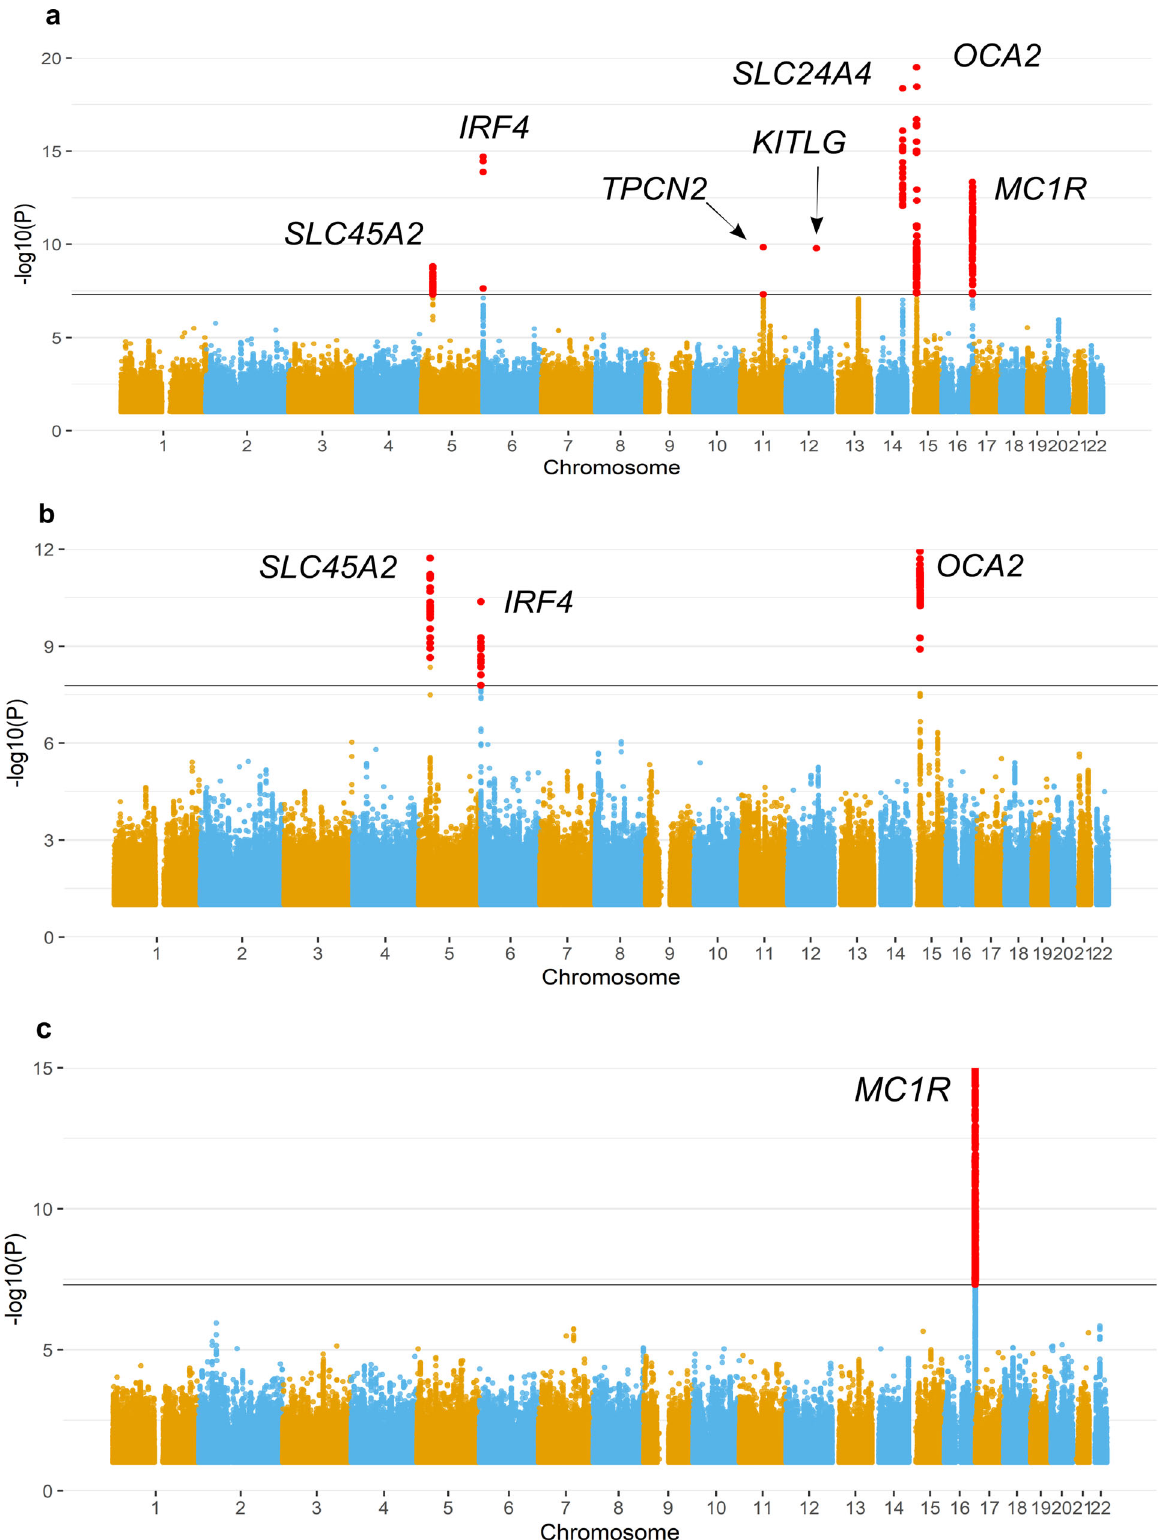
Fig. 2 Manhattan plots of hair colour meta-analyses based on logistic mixed models. a Blonde vs. brown + black hair colour ( n = 12,398 individuals). b Brown vs. black hair colour ( n = 10,990 individuals). c Red vs. brown + black hair colour ( n = 10,450 individuals). The continuous black line denotes the genome-wide signi fi cant threshold ( p = 1.66e-8). Markers in red are genome-wide signi fi cant. The Y-axis has been limited to truncate strong signals of association. The full fi gure is available as Supplementary Fig.